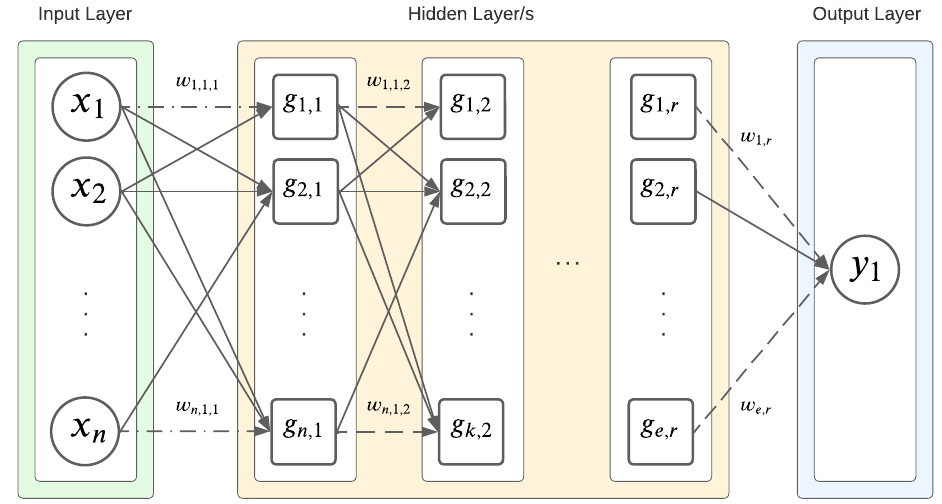
Figure 7. Feed forward neural network architecture. Table 5. Neural network cases that are applicable to M&V